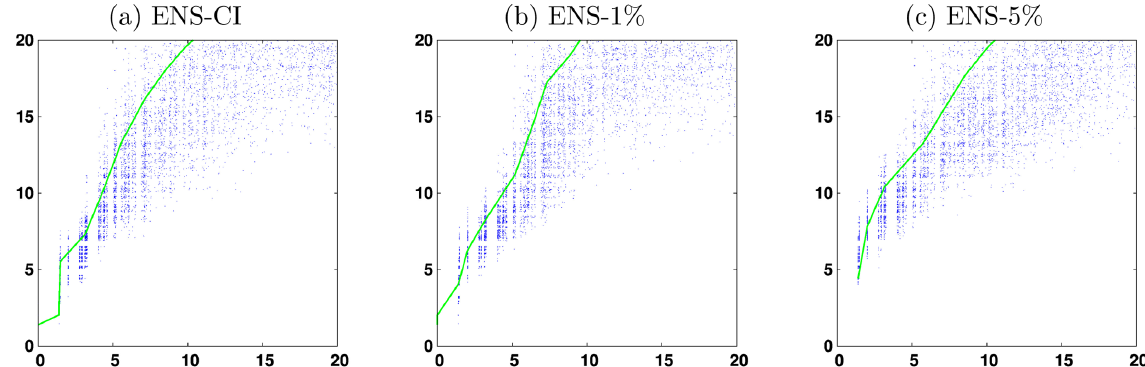
Figure 17. Final location score ( y axis, in km) as a function of the initial location score ( x axis, in km) for SST and time lag (cid:49)t = 5d. The green line corresponds to the initial score required to have a 95% probability that the final score is below a given value. The figure compares the three simulations ENS-CI (no model uncertainty, a ), ENS-1% (small model uncertainty, b ) and ENS-5% (larger model uncertainty, c ) for the small location scores (smaller than